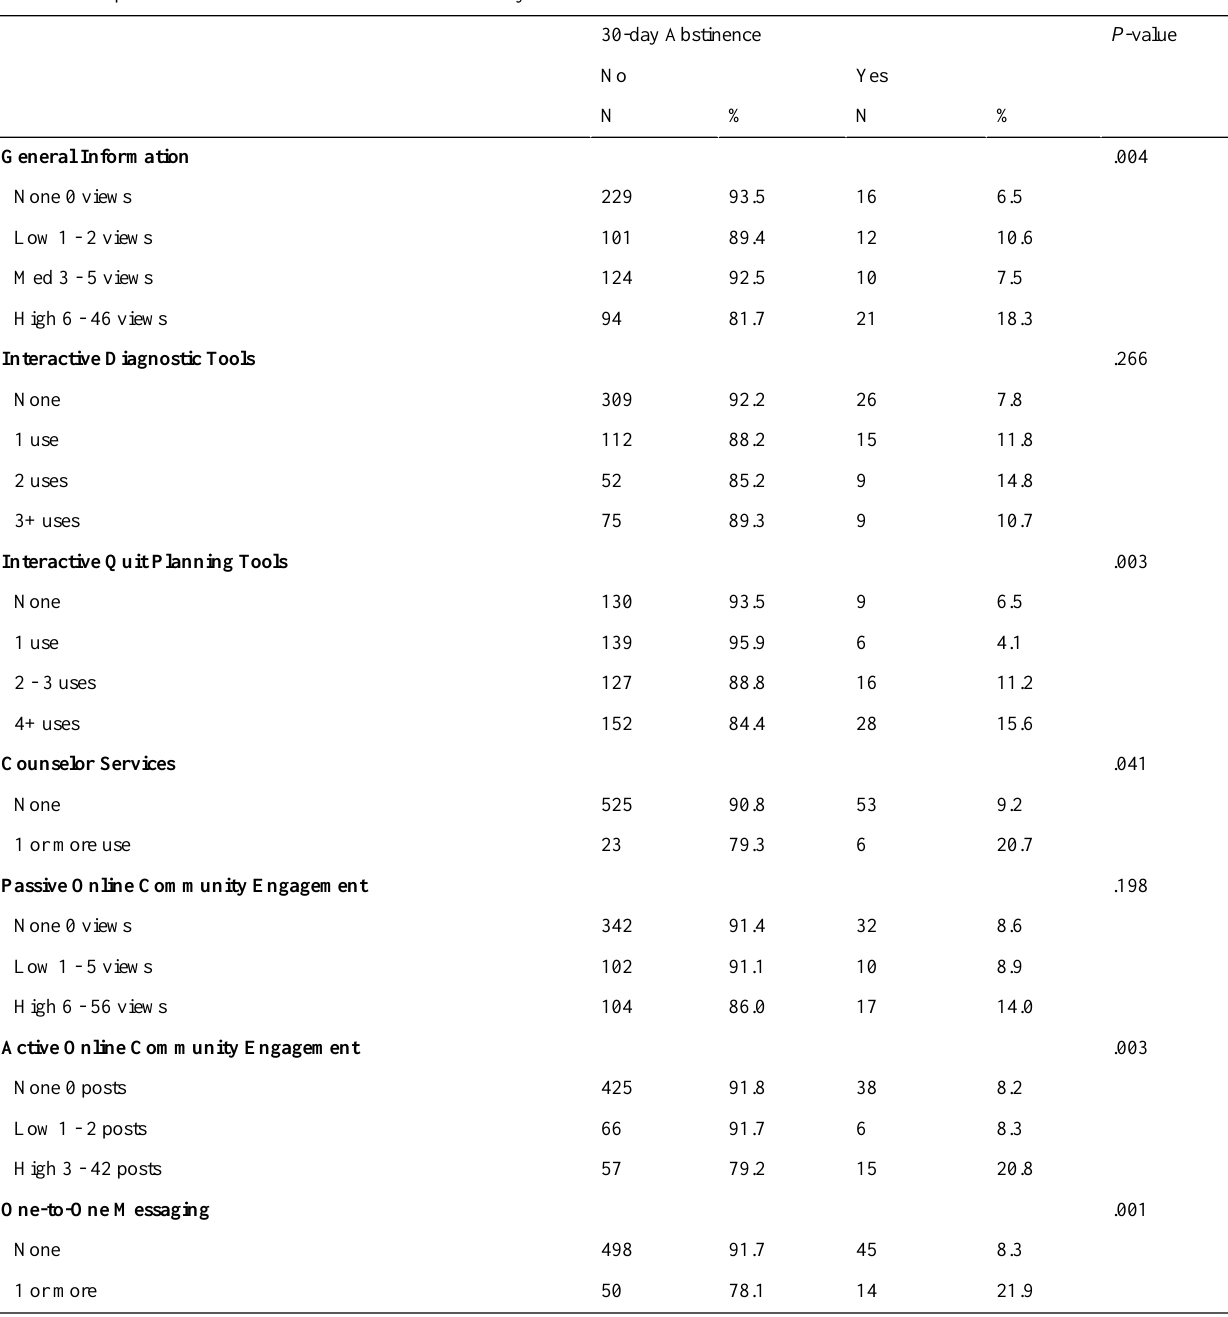
Table 4. Comparison of website feature utilization and 30-day abstinence rates